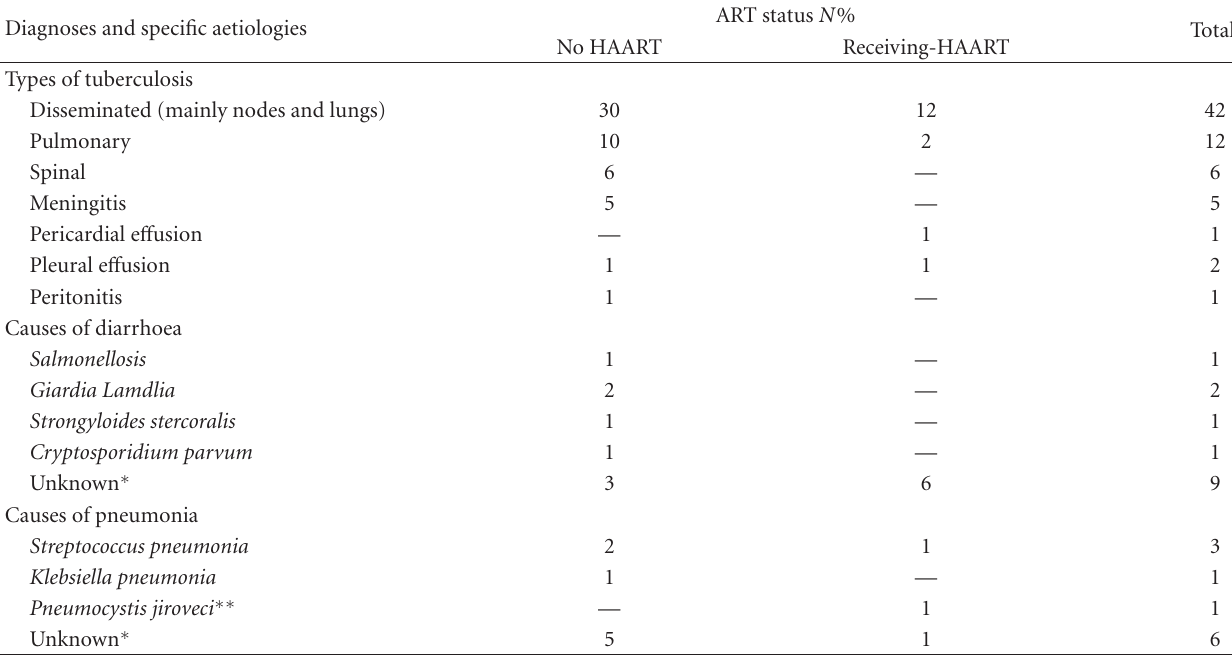
Table 3: Types of tuberculosis and specific aetiological diagnoses in patients in relation to antiretroviral therapy status. Diagnoses and specific aetiologies